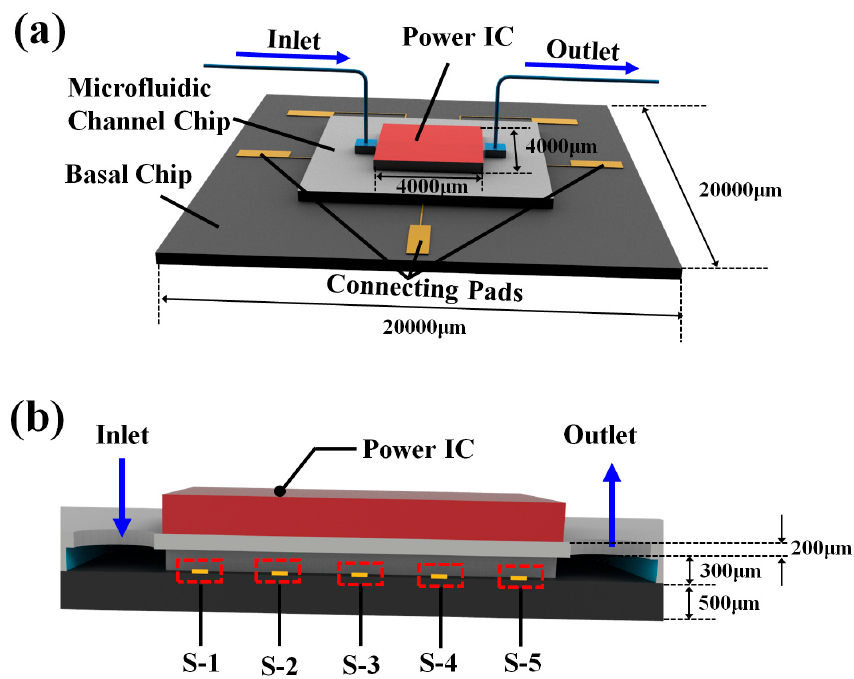
Figure 1. ( a ) Schematic drawings of microchannel heat sink structure and ( b ) cross-sectional view along the central microchannel, where the thin film temperature sensors are denoted as S-1 to S-5. The MCHS consists of three parts, including the power IC (working as heat source, and its dimensions are 4000 × 4000 μ m), microfluidic channel chip, and basal chip. The microfluidic channel chip and basal chip are both made of silicon. The microfluidic channel chip consists of 50 rectangular micro channels, and the dimensions of each channel are 50 × 300 × 5000 μ m (the width is 50 μ m, the depth is 300 μ m, and the length is 5000 μ m). The micro channels are fabricated by dry etching. Five temperature sensors, denoted as S1 to S5, are equally distributed in the central fluidic channel from inlet to outlet. The interval of each sensor is 1000 μ m, shown in Figure 1b. Pt thin-film is deposited and patterned as the temperature sensor. The benzocyclobutene (BCB) epoxy is used for chip